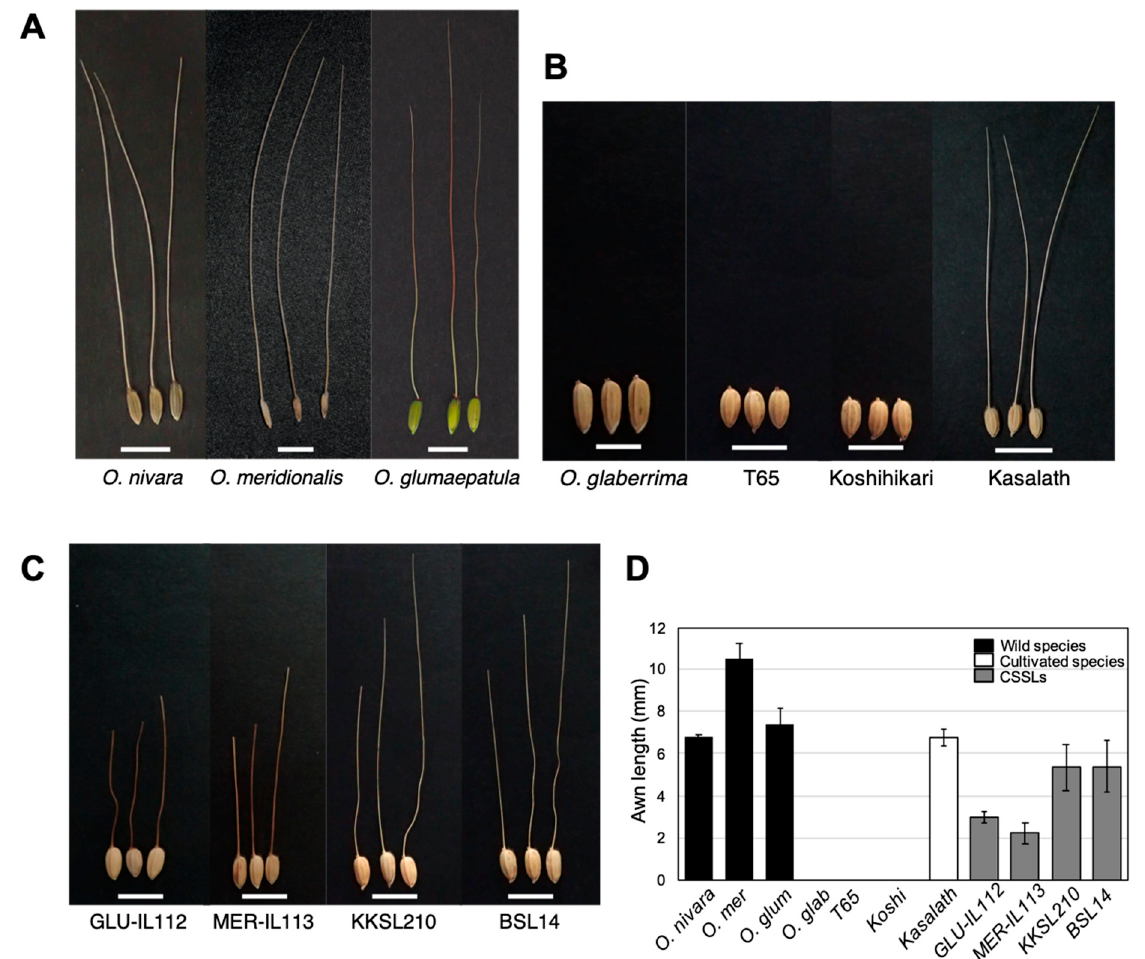
Figure 2. Awn phenotypes of materials. ( A , B ) Seeds of selected CSSL parents among ( A ) wild rice species and ( B ) cultivated rice species. African cultivated rice: O. glaberrima , Asian cultivated rice: T65 ( O. sativa, japonica ), Koshihikari ( O. sativa, japonica ), Kasalth ( O. sativa, indica ( aus )). ( C ) Seeds of several CSSLs possessing awns. ( D ) Awn lengths for each line. Average awn length of ten seeds ± SD. Scale bar = 1 cm. O.mer, O. meridionalis ; O.glum, O. glumaepatula ; O.glab, O. glaberrima ; T65, Taichung 65; Koshi, Koshihikari.